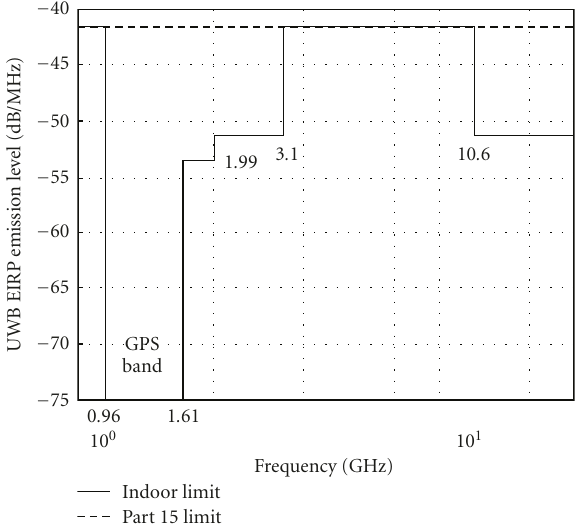
Figure 5: FCC spectral mask for indoor UWB